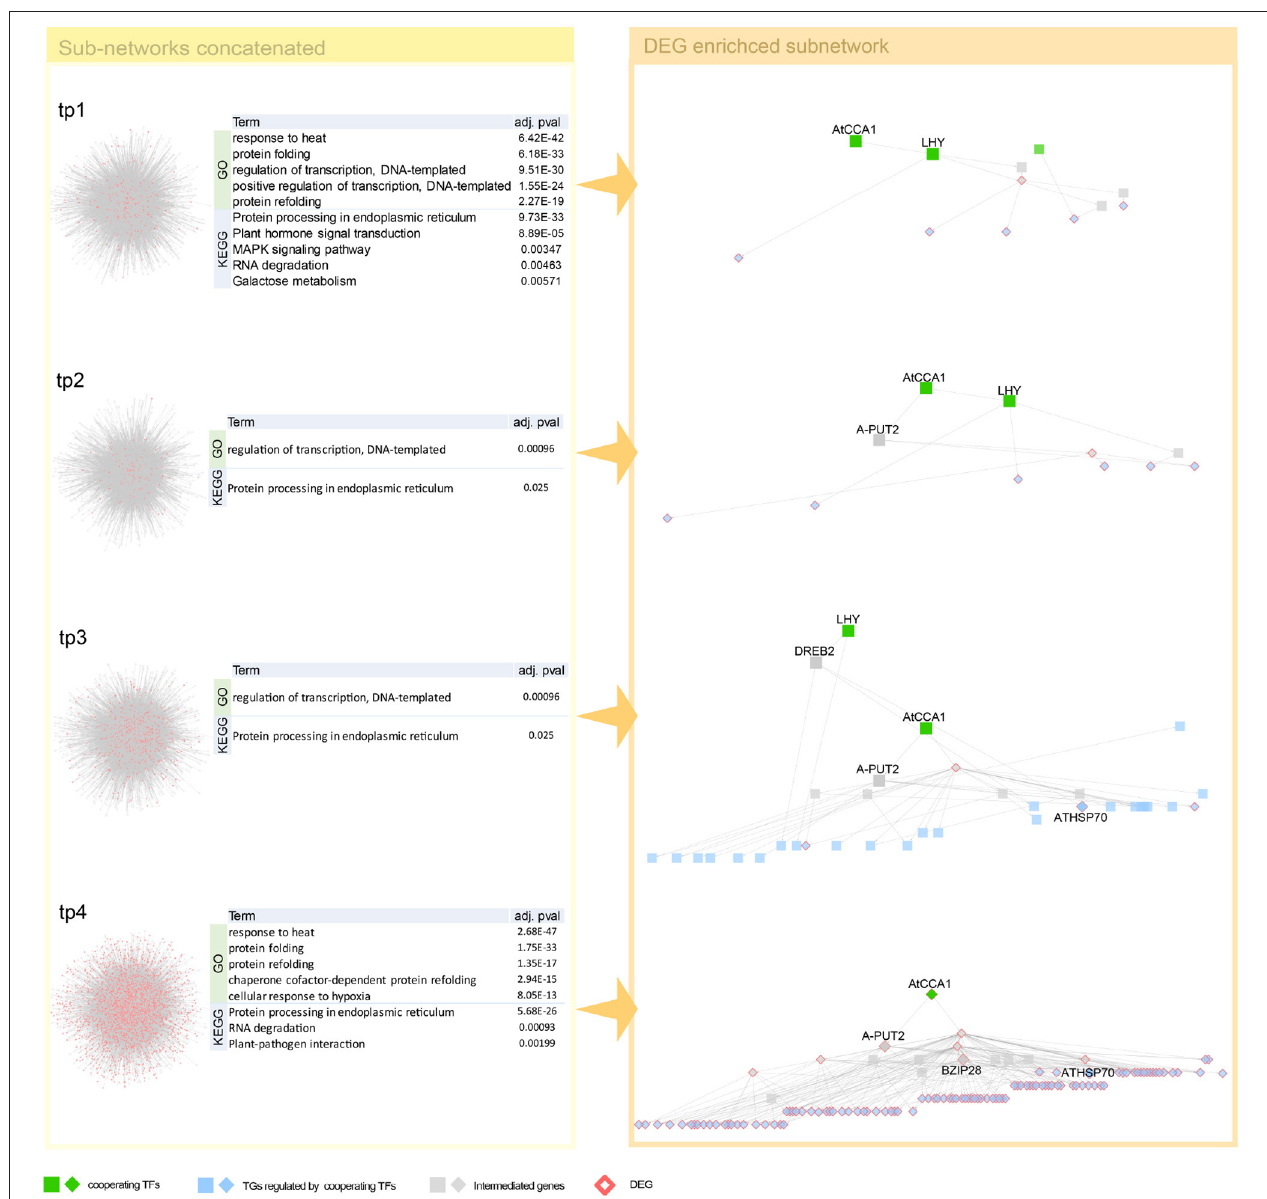
FIGURE 4 | Network dynamics of a gene regulatory network (GRN) sub-network after heat stress over time. Network in the left panel shows the change in gene-gene relationship, in particular, TF–TG regulation. DEGs are denoted as pink. Four tables in the middle summarize top five most enriched biological pathways with p -value corrected by false discovery rate (FDR) < 0.05. Heat stress related Gene Ontology (GO) terms are enriched in GO enrichment tests with DEGs. The networks in the right panel are dynamics of a TF–TG sub-network that are DEG enriched. Transcription factors (TFs) were denoted with green nodes. Blue nodes denote target genes (TGs) and gray nodes denote genes connected to TFs and TGs. Square nodes denote DEGs that are detected by Limma with FDR <